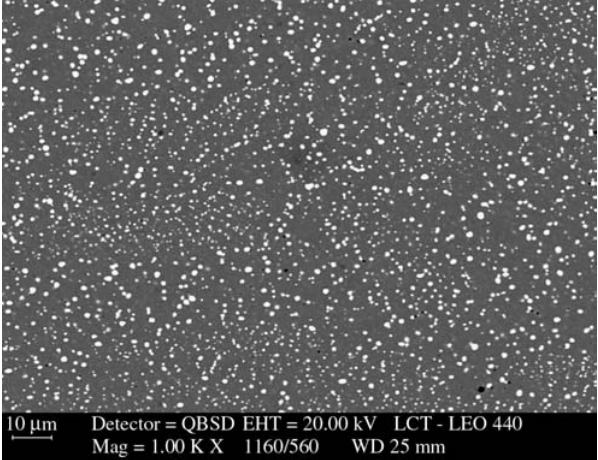
Figure 2. Scanning electron micrograph of Sinter 23 austenitized at 1160 °C and tempered at 560 °C.